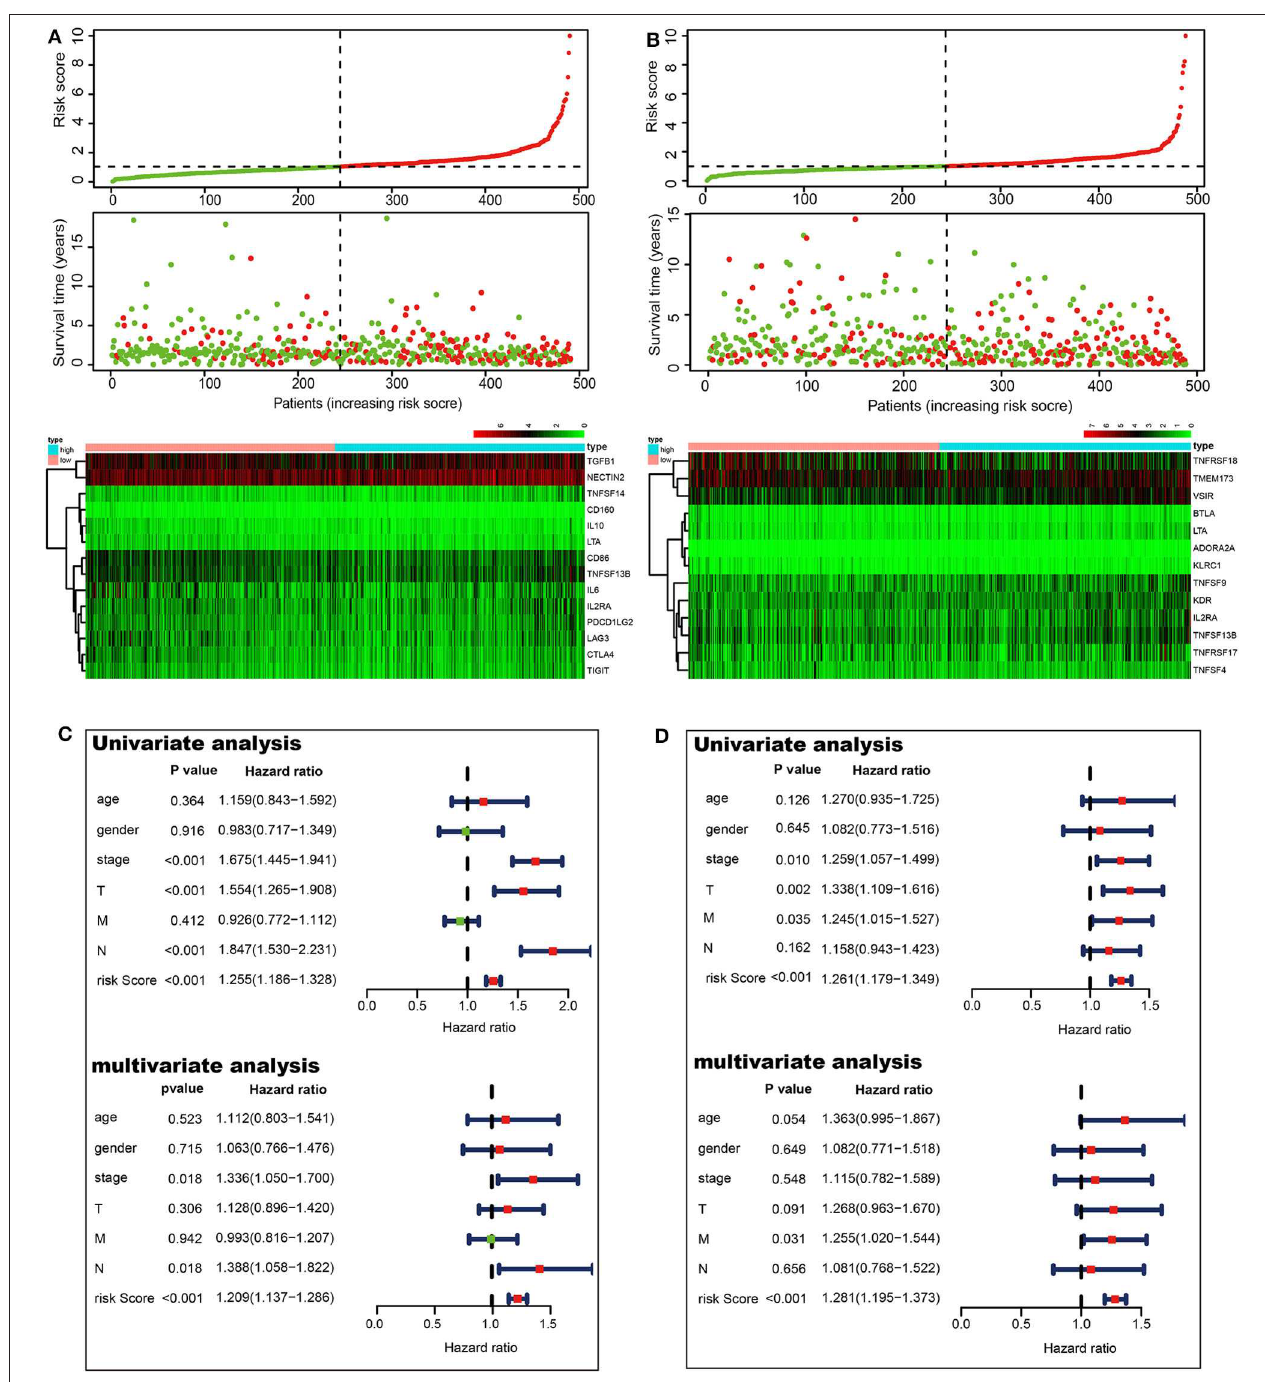
FIGURE 7 | Prognostic values of the risk scores in The Cancer Genome Atlas lung cancer cohorts. Distribution of risk scores, along with survival statuses, and gene expression profiles for LUAD (A) and LUSC (B) . Univariate and multivariate Cox regression analyses of the risk score in LUAD (C) and LUSC (D) regarding overall